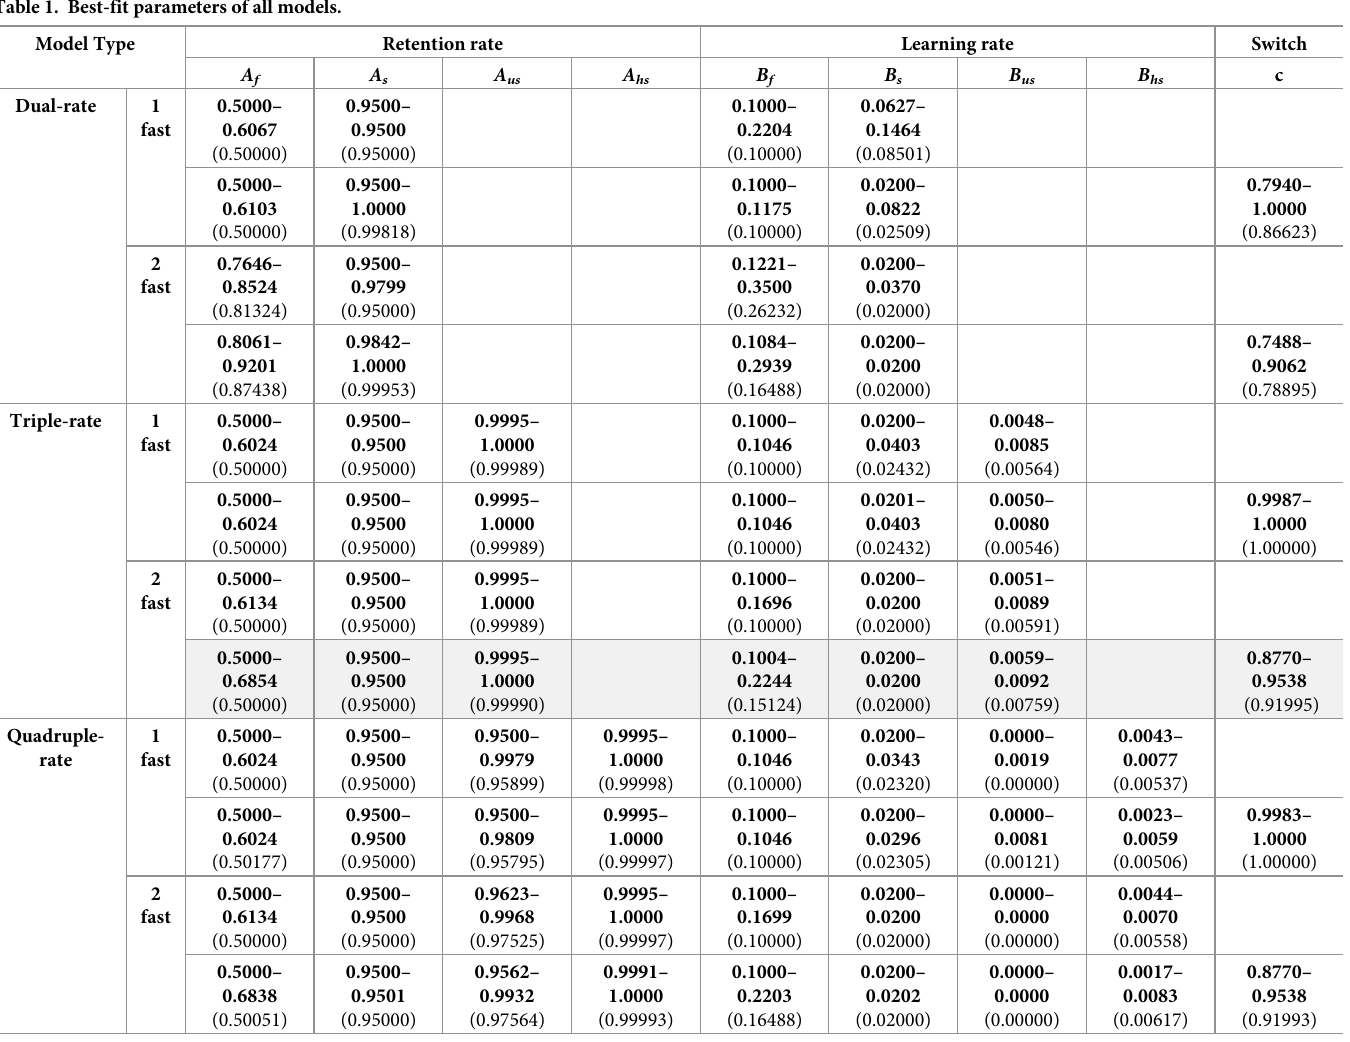
Table 1. Best-fit parameters of all